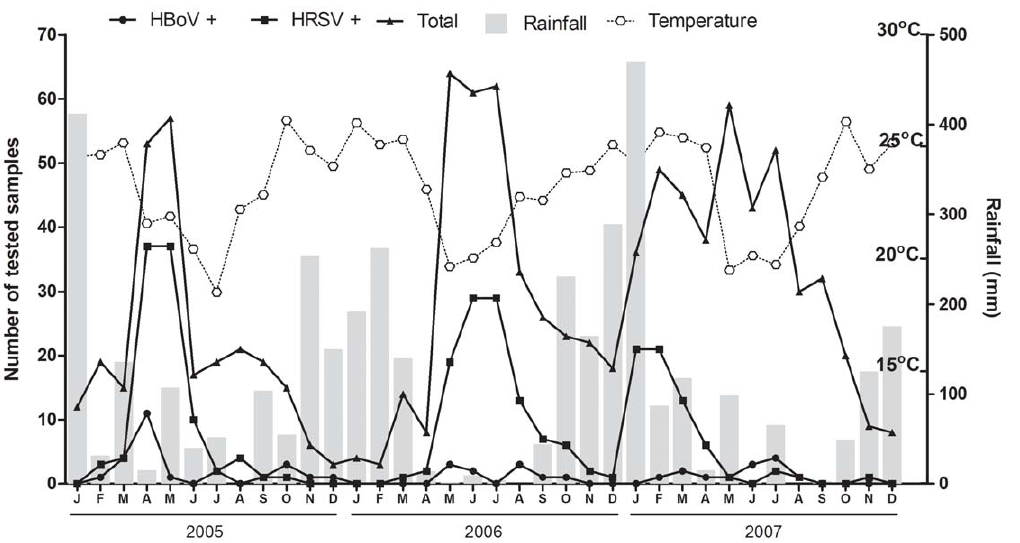
Figure 1. Monthly distribution of samples positive for HBoV and HRSV in the years 2005 through 2007 in Ribeira˜o Preto, Brazil in relation to monthly accumulated rainfall and average temperauture (http://www.ciiagro.sp.gov.br).